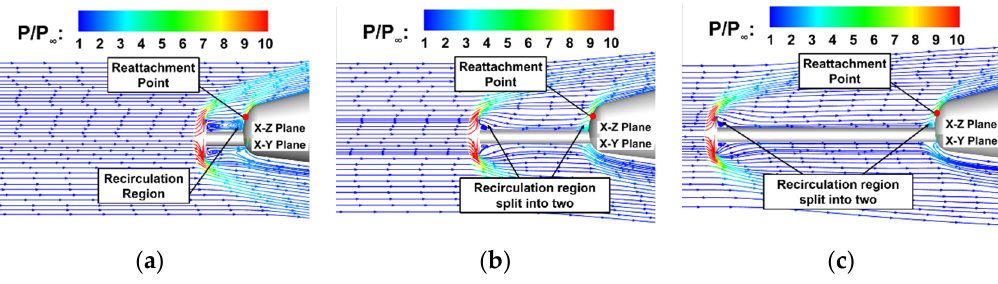
Figure 11. Comparison of crossflow Reynolds number and boundary layer thickness at X = 300 mm. ( a ) comparison of Re CF , ( b ) comparison of δ .